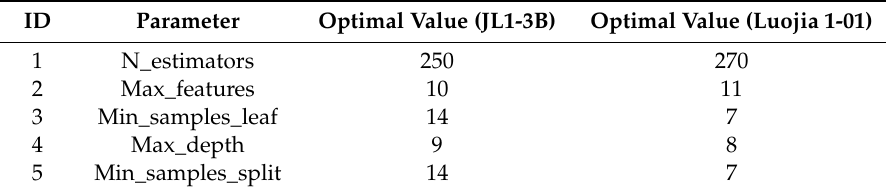
Table 5. Optimal RF regression model parameters